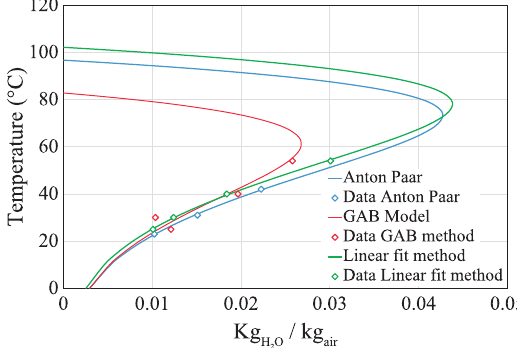
Fig. 5 Mollier diagram of the coffee creamer material derived from the sticky points obtained via the Anton Paar Rheometer and the DVS system (GAB model and lin - ear fit).